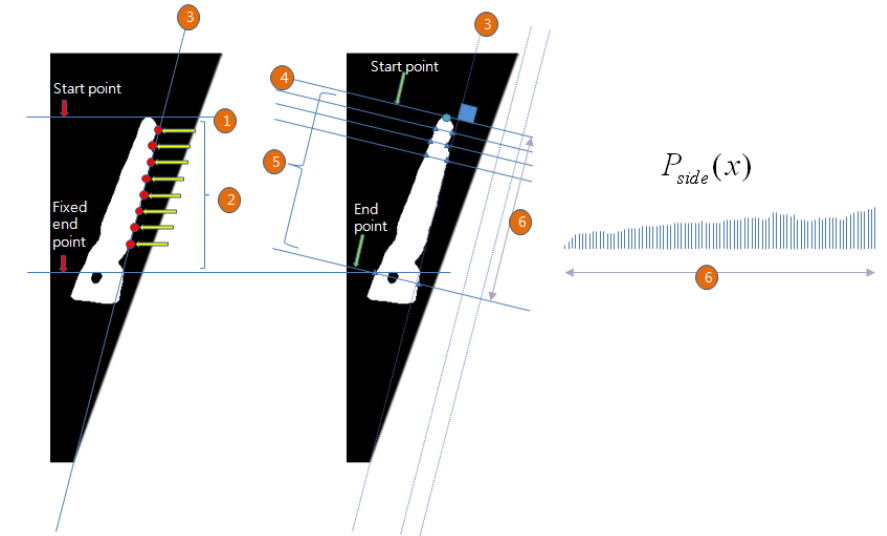
Figure 6. Thickness search of the side view of the hand and the profile of the thickness.